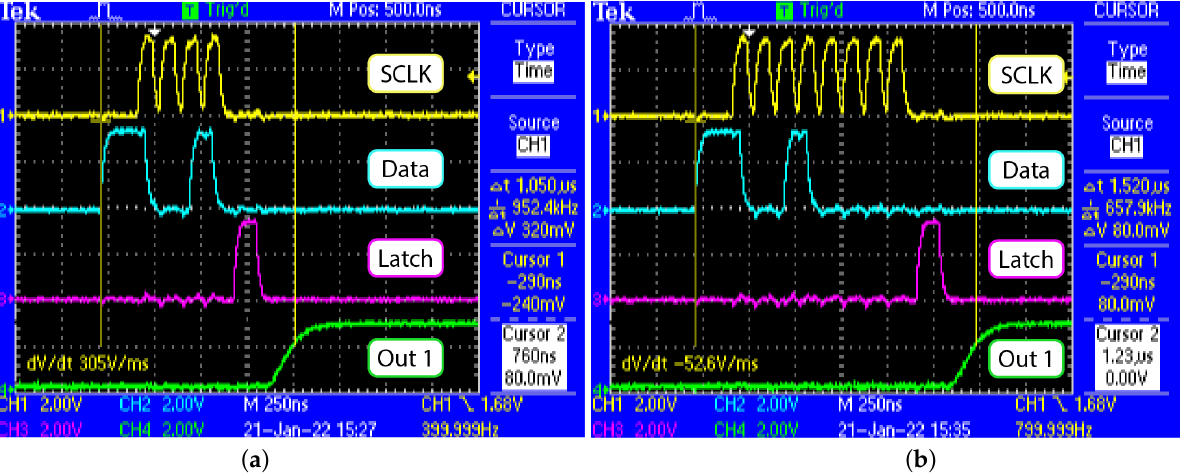
Figure 21. Shift-register data transfer and output update, for the cases of 4 and 8 used bits. ( a ) Four output bits used (demo default). ( b ) Eight output bits